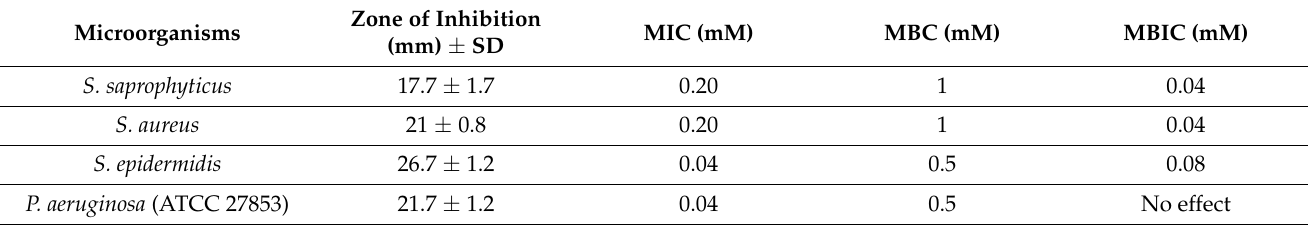
Table 1. Zone of inhibition (mm ± SD), MIC, MBC, and MBIC of β